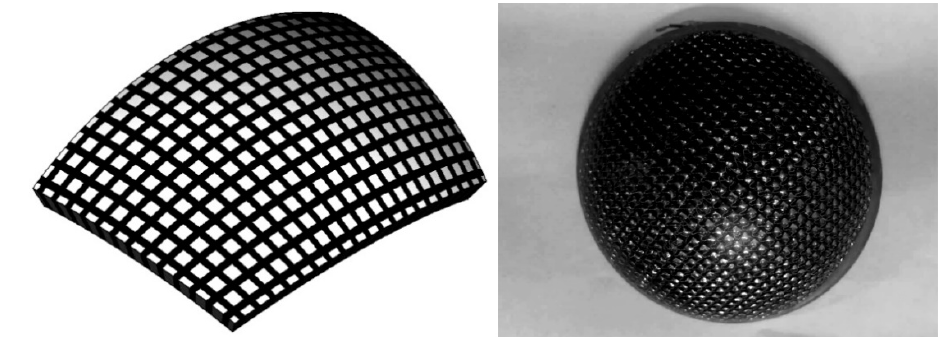
Figure 27. Spherical structure with square piezoelectric ceramics.